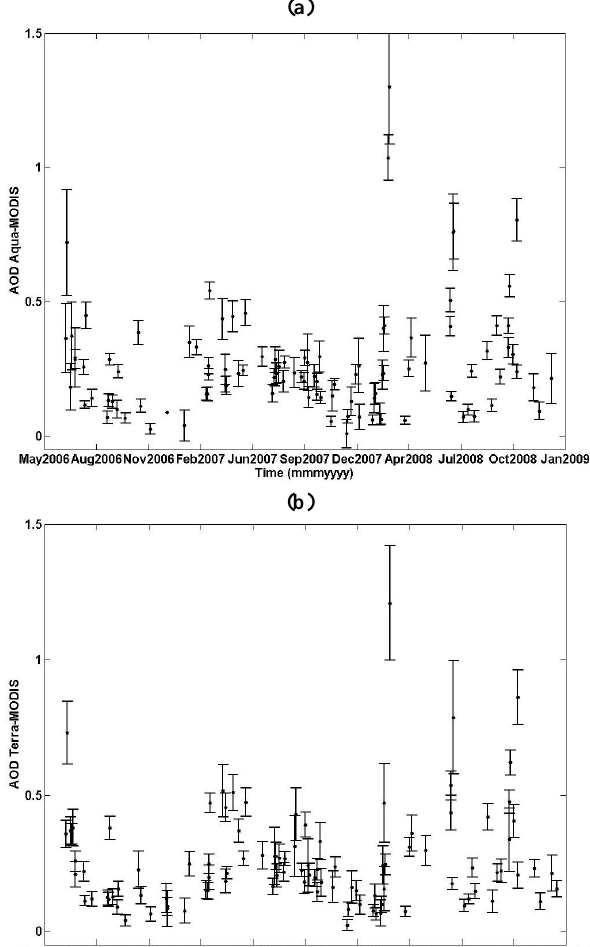
Fig. 3: Temporal evolution of the mean AOD at 550 nm (τ MO ) under CALIPSO ground track between June 2006 and February 2009 from (a) MODIS-Aqua (102 data) and (b) MODIS-Terra (104 data) for the situations where both CALIOP and MODIS data are available. The errorbars represent the standard deviation σ MO associated with each AOD value.